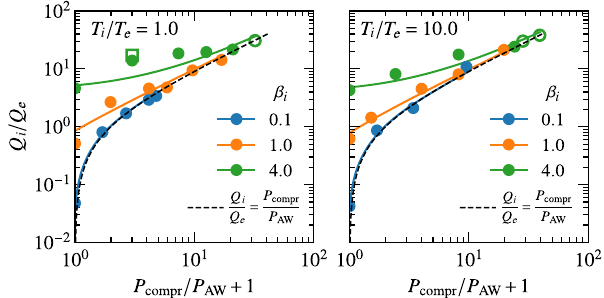
=Q FIG. 1. Dependence of ion-to-electron heating ratio Q i e 1 (left) and T 10 (right). =P =T =T on P for T i e ¼ i e ¼ compr AW The markers are simulation results, and the lines are the prescription (14). The colors correspond to different values of β =Q P =P . The dashed lines correspond to Q . The i i e ¼ compr AW closed circles correspond to the “ fiducial ” box runs, the open circles to the “ double-sized ” box runs, and the green open square to the higher-velocity-space-resolution run (see Sec. III). The =Q value of Q obtained in this higher-velocity-space-resolution i e run is nearly identical to that of the “ fiducial ” box run with the ; T =T ; P =P same ( β ), demonstrating numerical conver- i i e compr AW gence with respect to the velocity